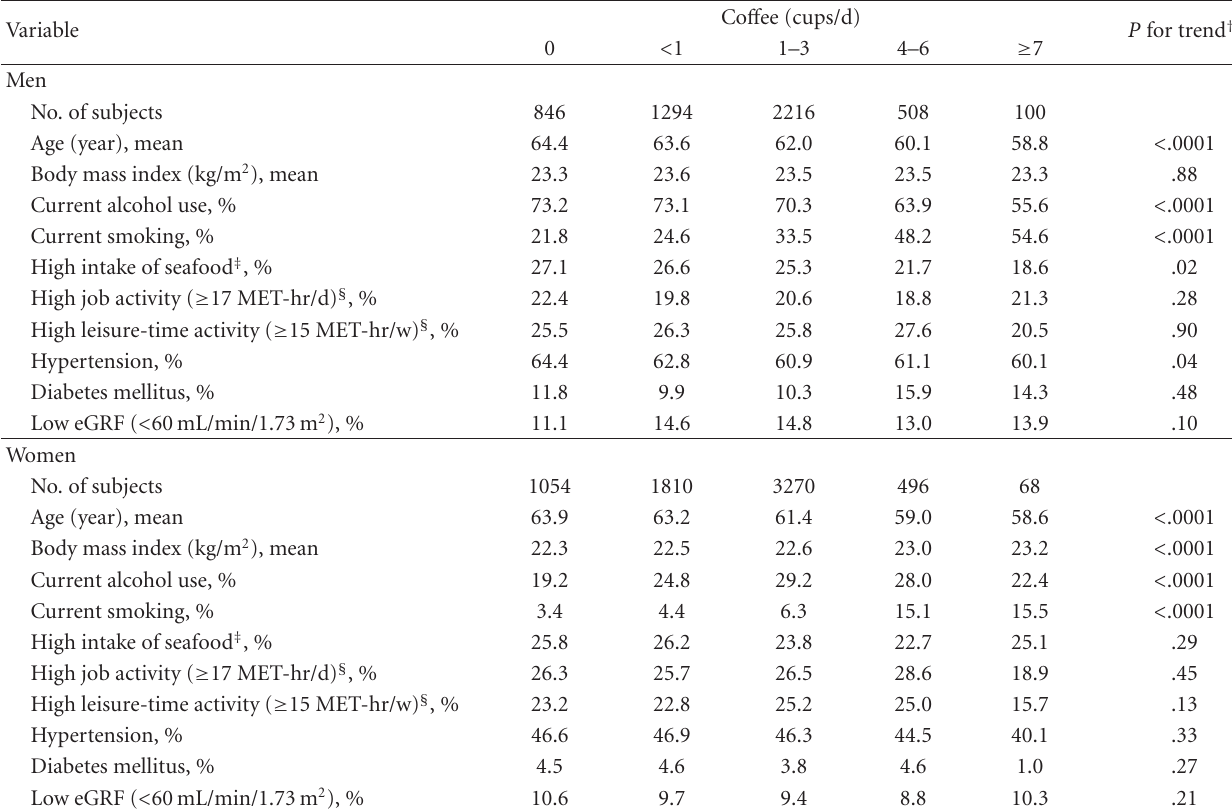
Table 2: Age-adjusted means and proportions of possible confounders according to co ff ee consumption levels by sex ∗ . Variable